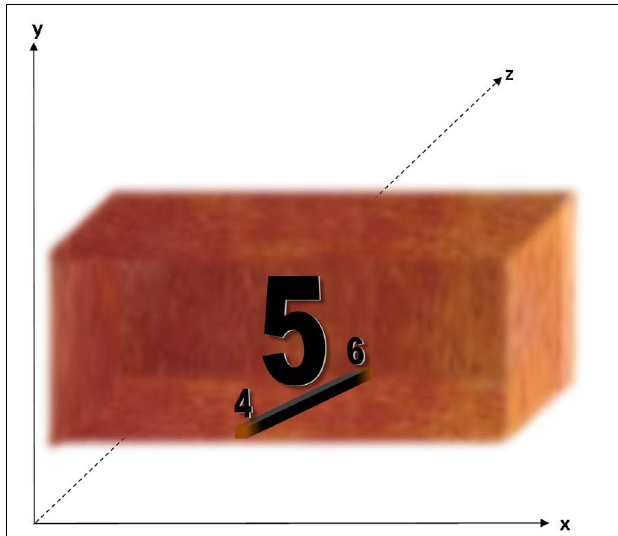
FIGURE 6 | The “corridor” context, which appears when concurrents are viewed as part of a sequence. The corridor has a 3D structure, with walls, a floor and ceiling, and red-orange